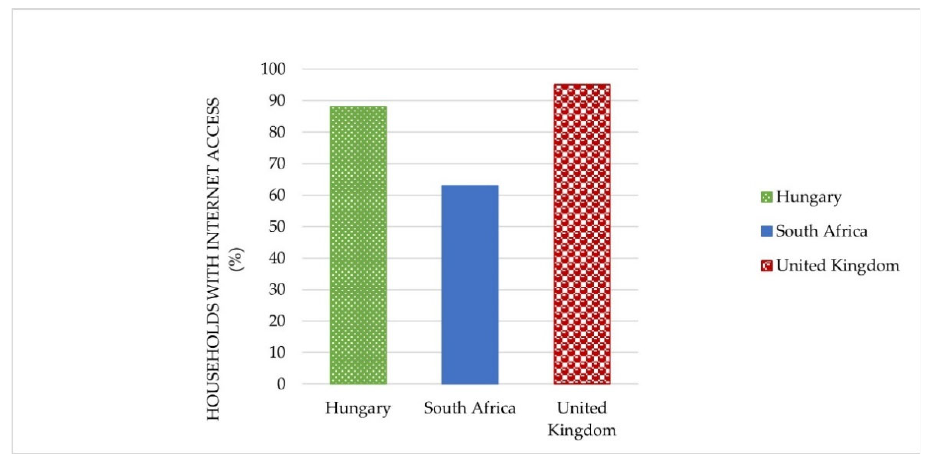
Figure 7. Households with Internet access at home (%) [13].